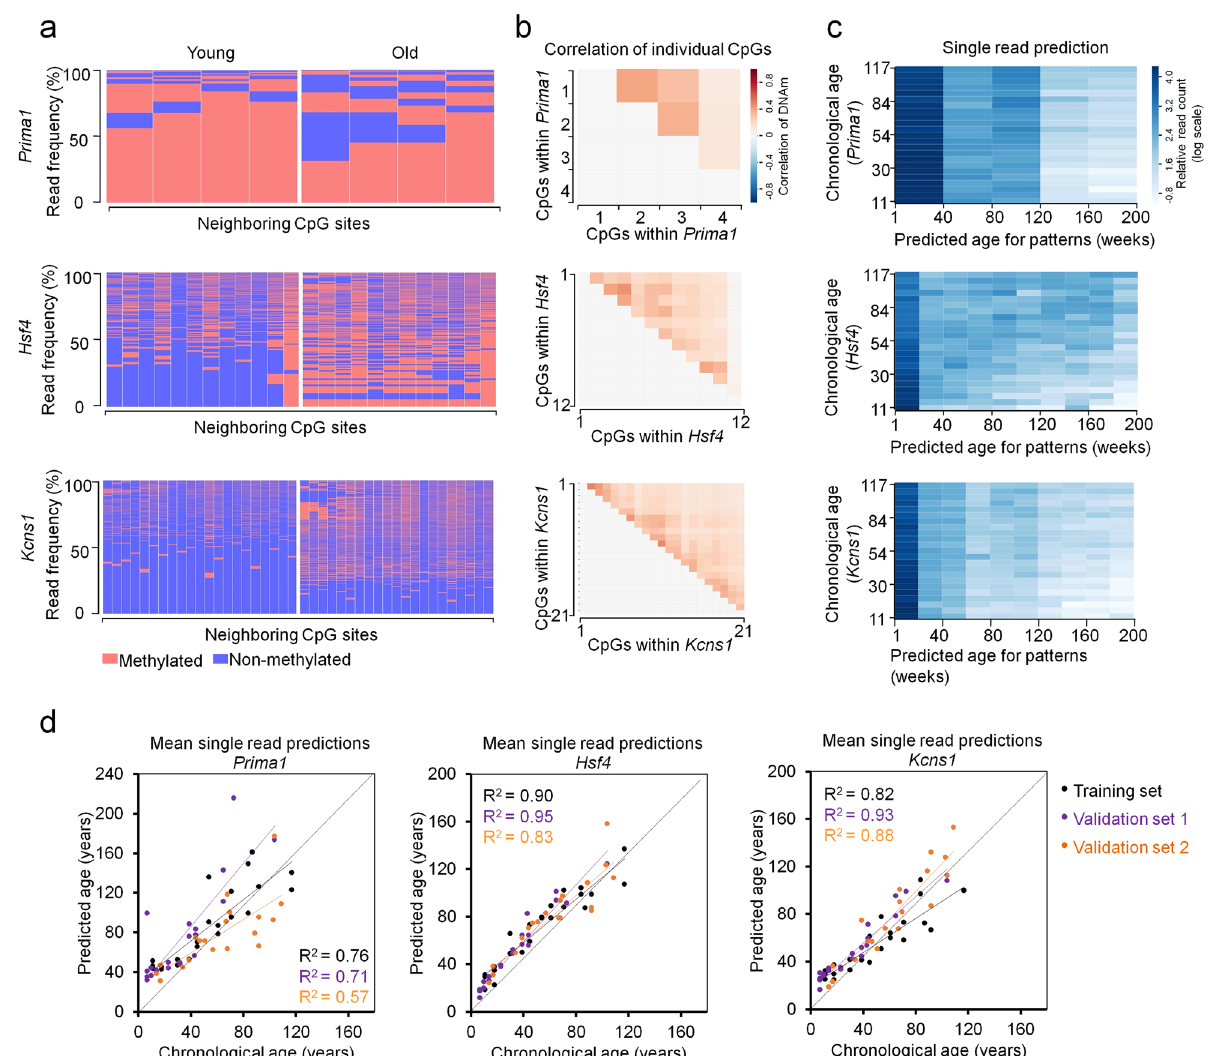
Figure 4. Analysis of age-associated DNAm patterns within individual BBA-seq reads in C57BL/6 mice. ( a ) Frequencies of DNAm patterns in BBA-seq reads (red: methylated; blue: non-methylated) within the amplicons of Prima1 (4 neighboring CpGs), Hsf4 (12 neighboring CpGs) and Kcns1 (21 neighboring CpGs). Samples of one young (11 weeks) and one old C57BL/6 mouse (117 weeks) from the training set are exemplarily depicted. ( b ) Pearson correlation of DNAm among neighboring CpGs within each of the three amplicons in BBA-seq data of the training set. ( c ) Epigenetic ages were estimated for each individual read of the BBA-seq data the training set (n = 23). These single-read predictions were performed for each amplicon based on the binary sequel of methylated and non-methylated CpGs. The heatmaps depict the relative frequency of reads (normalized by the read counts per sample; log scale) that are classified to a specific age category (between 0 and 200 weeks) for each donor in the training set. ( d ) The mean age-predictions based on individual BBA-seq reads of three amplicons were determined for each sample and then plotted against the chronological age of the training (n = 23) and two validation sets (n = 21 and n = 19) of C57BL/6